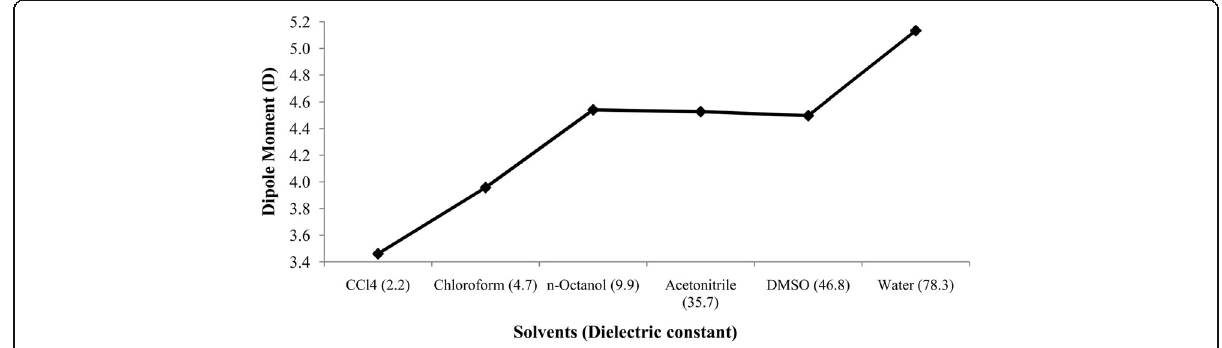
Fig. 8 Effect of solvent polarity on dipole moment (D) of betulinic acid